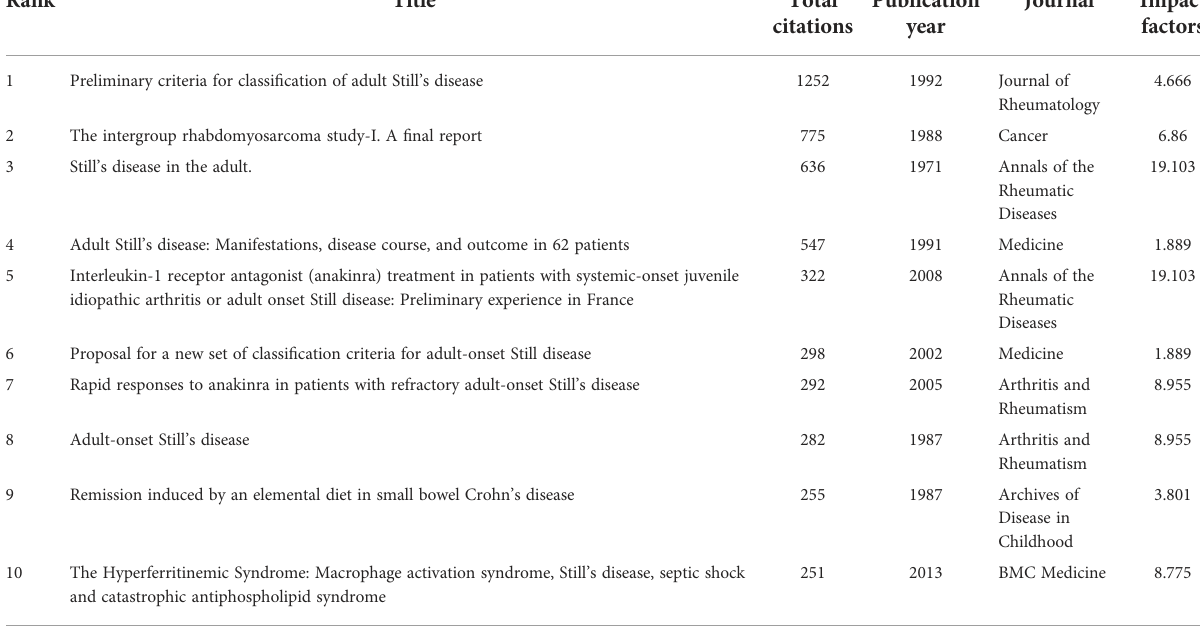
TABLE 2 Top 10 highly cited articles from 1921 to 2021. Rank